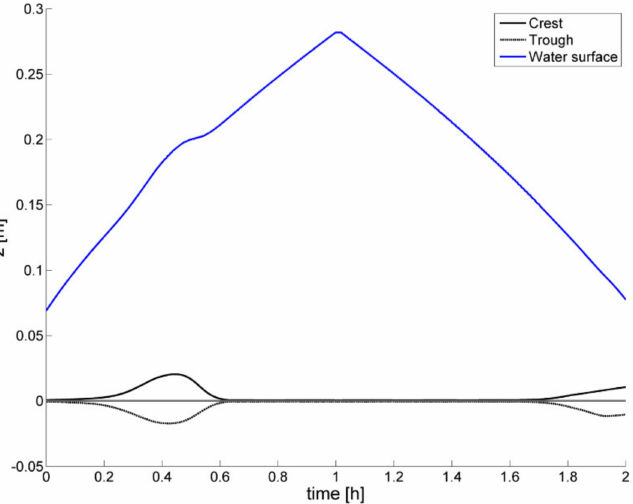
Figure 7. Dune crest and trough position (black lines) and water depth (blue line) over time, using scenario A4 from Shimizu et al.